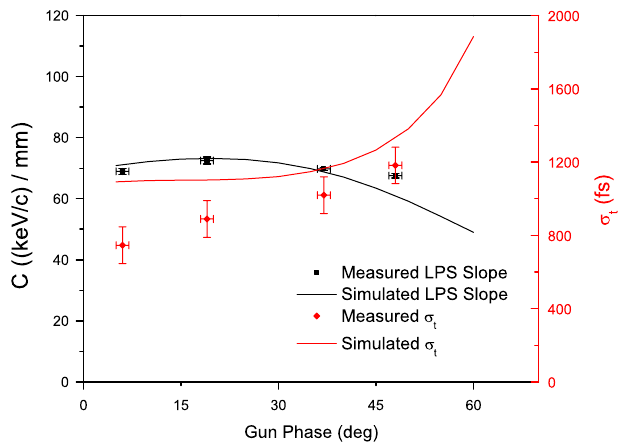
LONGITUDINAL PHASE SPACE . .